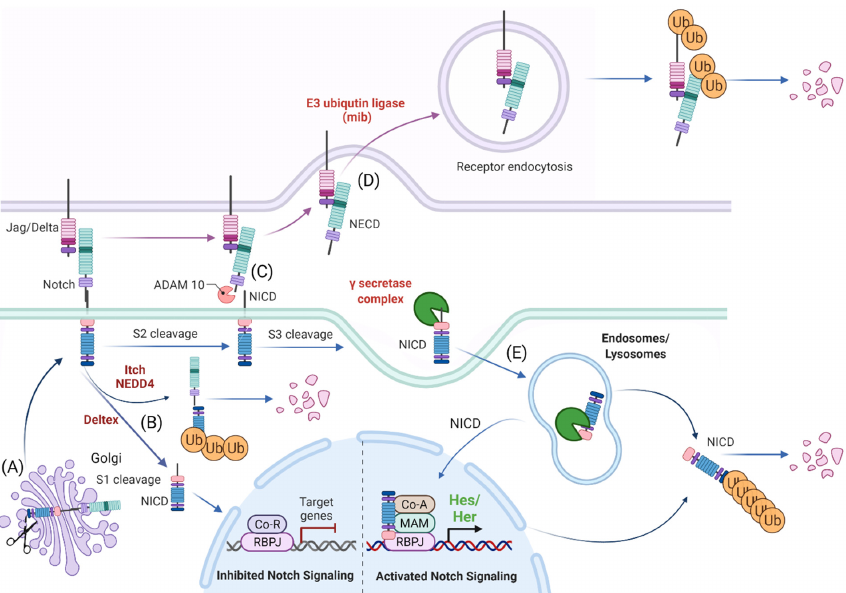
Figure 1. Schematic representation of Notch signaling molecule interaction, their localization within the cellular compartment and their life cycle. ( A ) Notch receptors undergo S1 cleavage in the Golgi vesicle. ( B ) Notch receptors can be directly degraded (without ligand interaction) via NEDD4/ITCH from the cellular surface or processed to Notch Intracellular Domain (NICD) in the absence of a Notch ligand by Deltex. ( C ) In the canonical Notch receptor processing, Notch receptor is cleaved upon contact with a ligand by ADAM family members at the c-terminal (intracellular) end that leads to exposure of the S3 cleavage site. ( D ) The ligand sending cell endocytoses the extracellular domain of the Notch receptor (NECD) that it “pulled off” when interacting with the receptor. ( E ) The NICD is then further processed by the γ -secretase complex to an activated NICD (cleavage at Val1744) within endosomes/lysosomes that can either be targeted for degradation or translocate to the nucleus for target gene modulation. Ub: ubiquitination, Co-R: undefined co-repressor, Co-A: undefined co-activator, MAM: MAML. Created with BioRender.com (accessed on 15 January 2022).